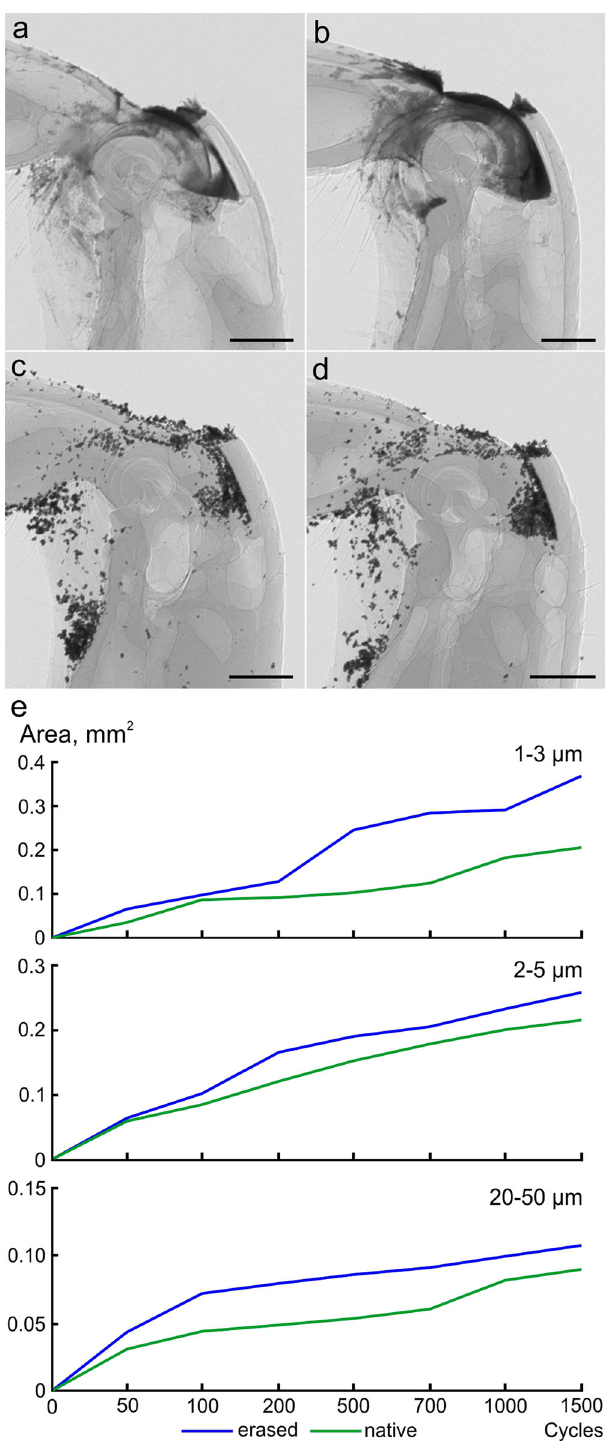
of the femur contains more particles (Fig. 3f) than in the experiment, where the hairy brush was not removed (Fig. 3b).